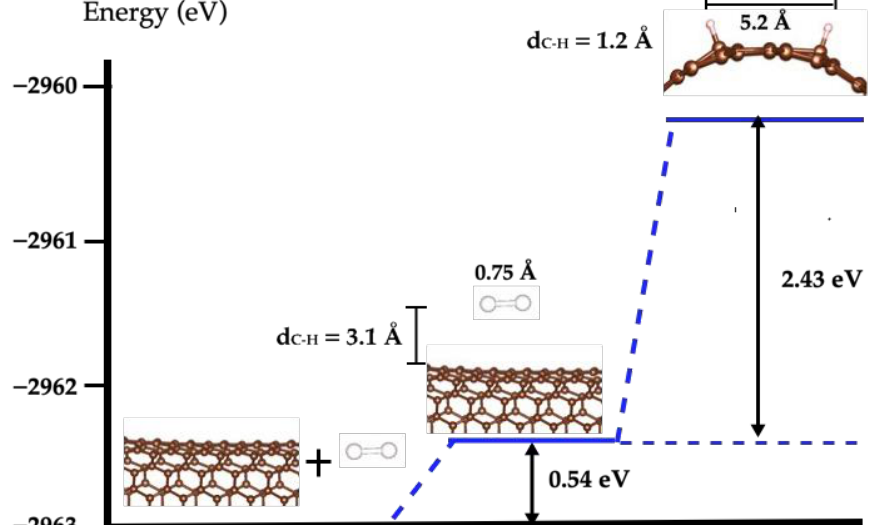
Figure 2. H 2 dissociation pathway in SWCN. The blue line marks the H 2 dissociation pathway. The brown spheres represent C atoms and white spheres are H atoms. The origin of the energy scale is the sum of the energy values of the isolated molecule and the bare SWCN.